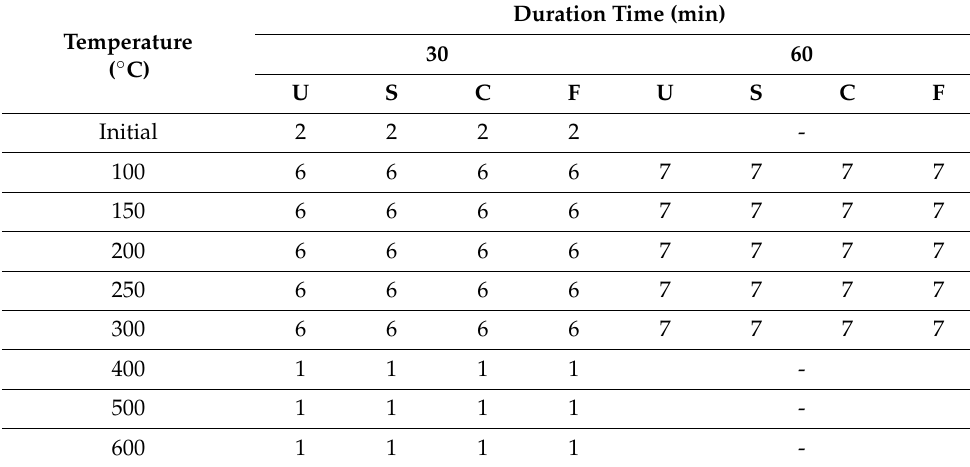
Table 6. Total number of test specimens.